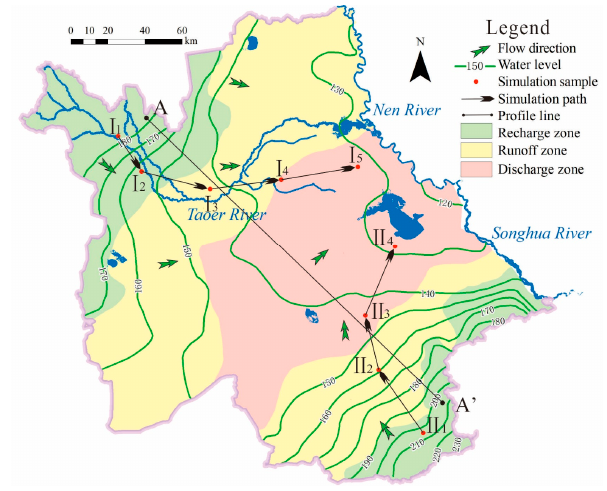
Figure 3. Groundwater chemical zonation/flow field and reverse chemical simulation path in the study